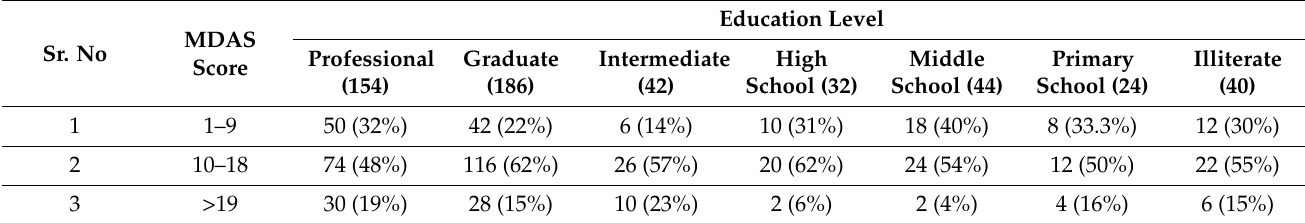
Table 3. Dental Anxiety Scores according to Education Level.